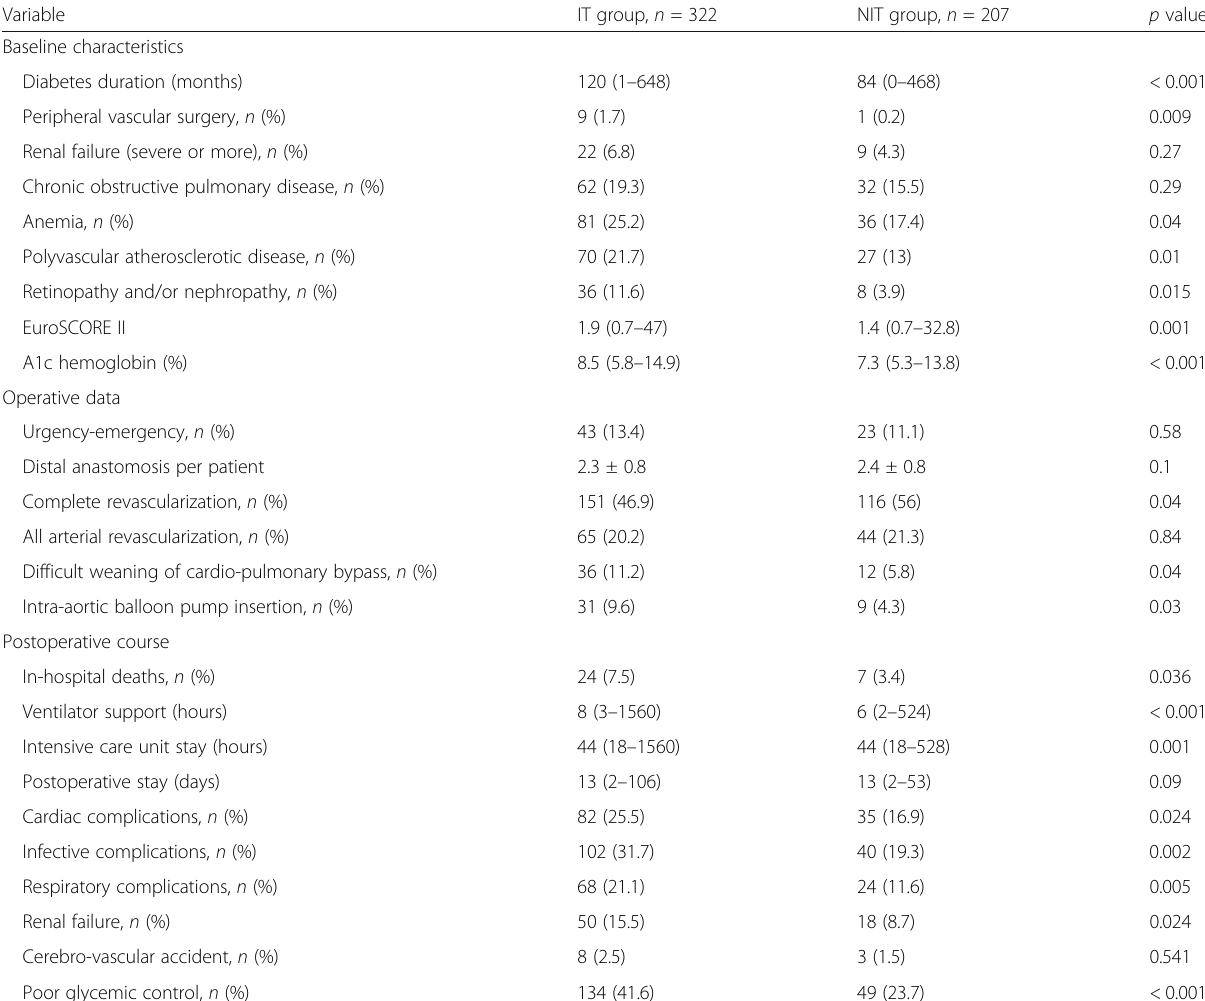
Table 4 Baseline characteristics, operative data, and outcome: comparison between insulin-treated and non-insulin-treated groups. Data are expressed as mean ± SD, median (range), and n (%) Variable IT group, n = 322